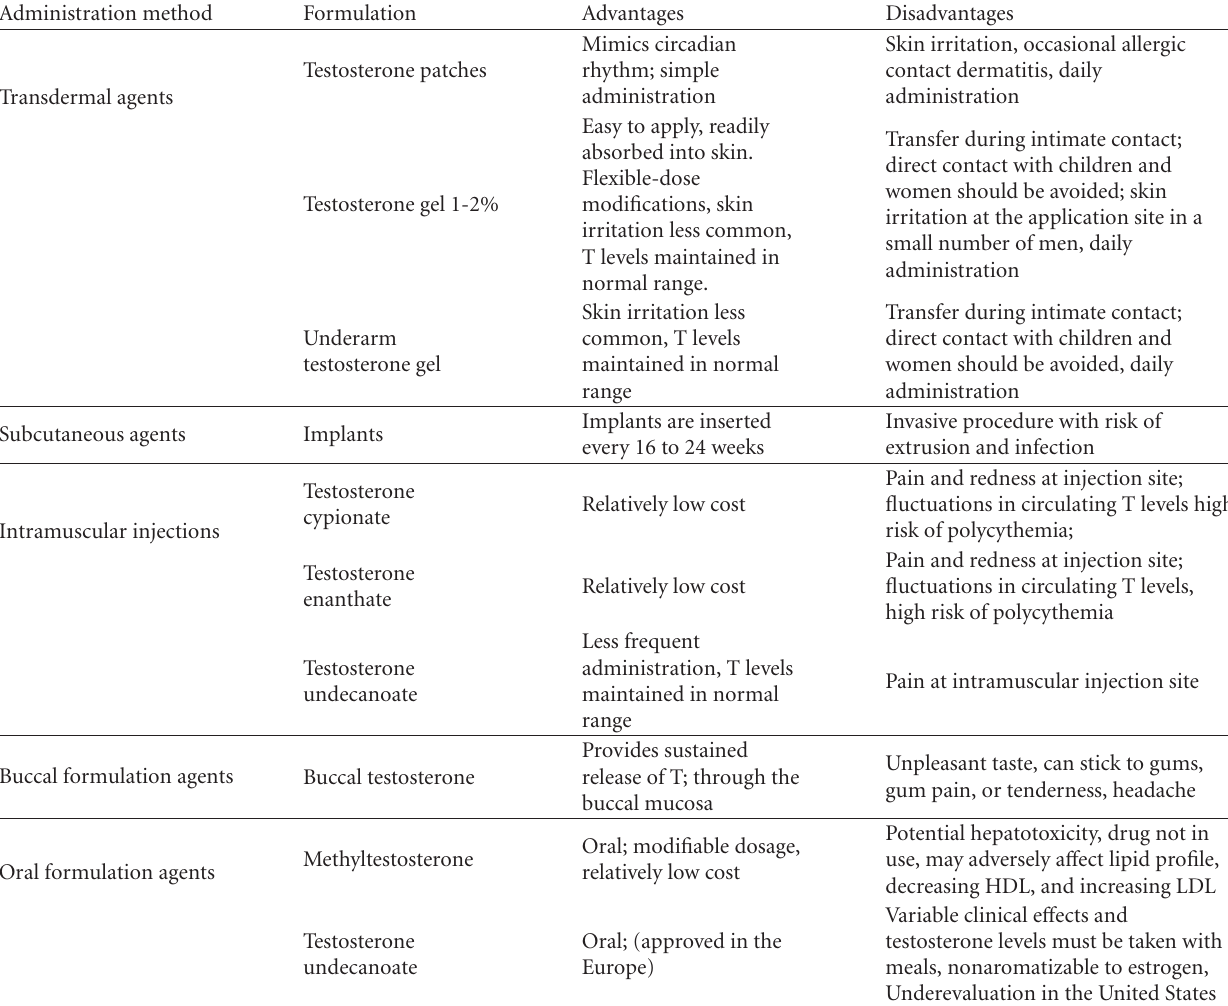
Table 3: Advantages and disadvantages of testosterone